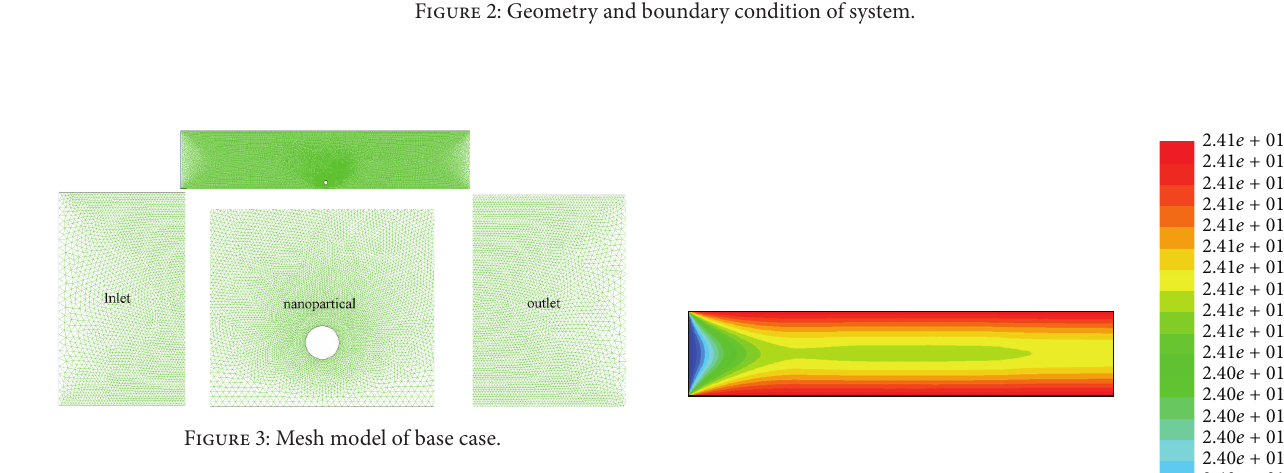
Figure 2: Geometry and boundary condition of system.